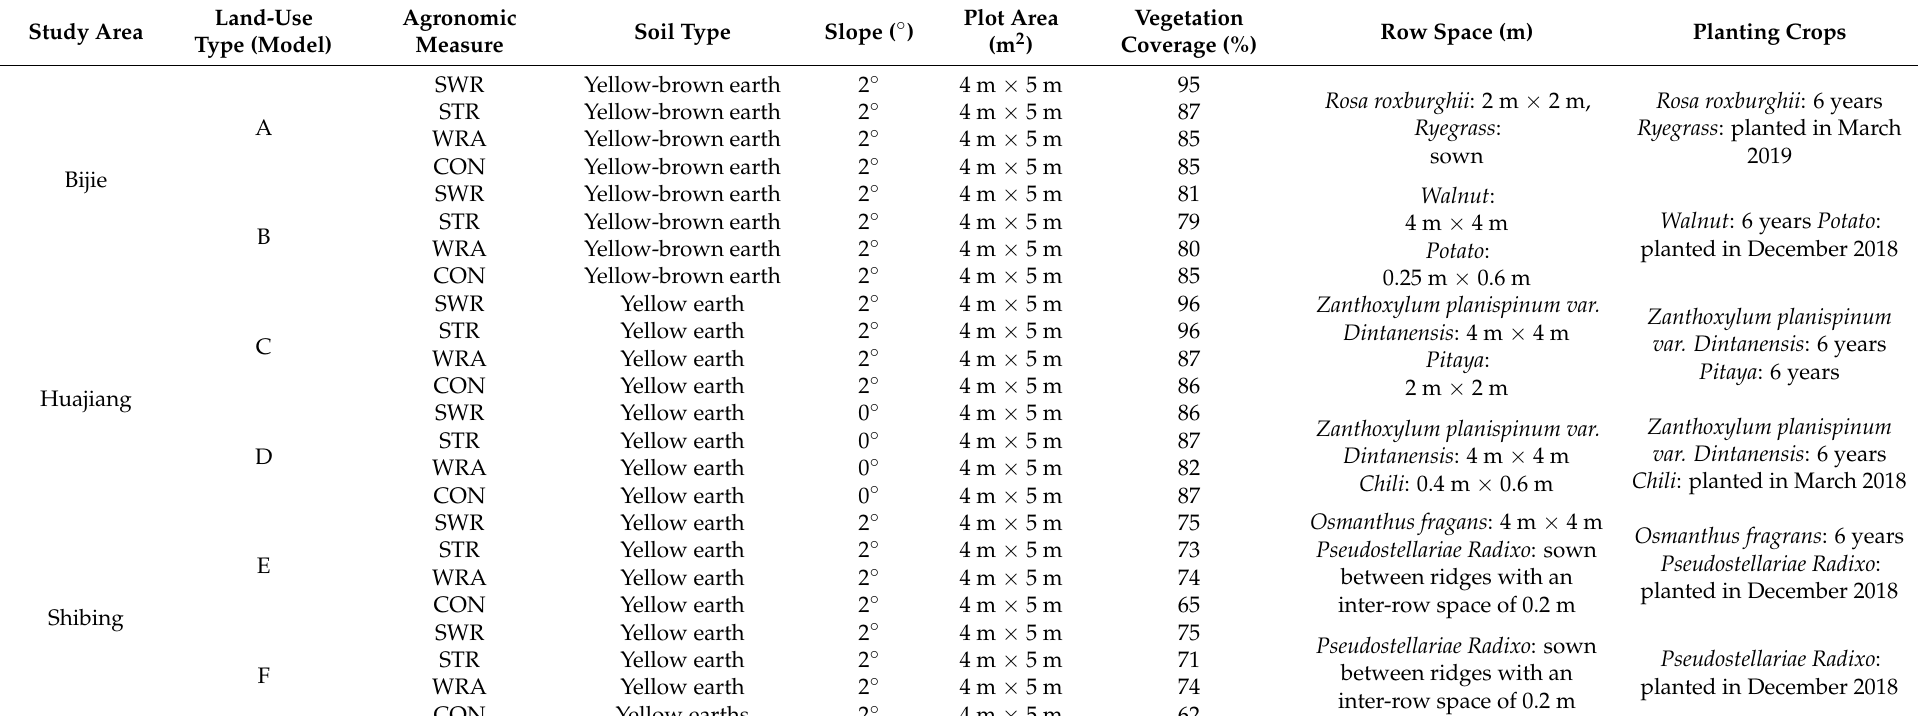
Table 1. Basic information of the sample plot in the study